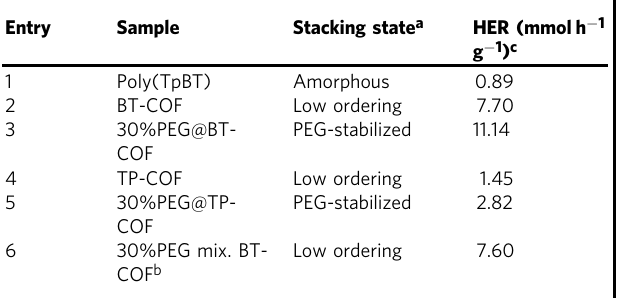
a Thestackingstatesigni fi esthenatureoflayeredstructuresduringthephotochemicalhydrogen evolution. b 30wt% of PEG was mixed with the BT-COF for the photoreduction reaction. c All HERs measured using the same instruments, optical setup, and reaction conditions: 10mg sample, 3.5±0.2wt% Pt, 0.1M ascorbic acid, 100mL water, 300W Xe light source equipped with λ >420-nm cut-off fi lter. HERs were obtained from the average 8-h photoirradiation and normalized to the sample